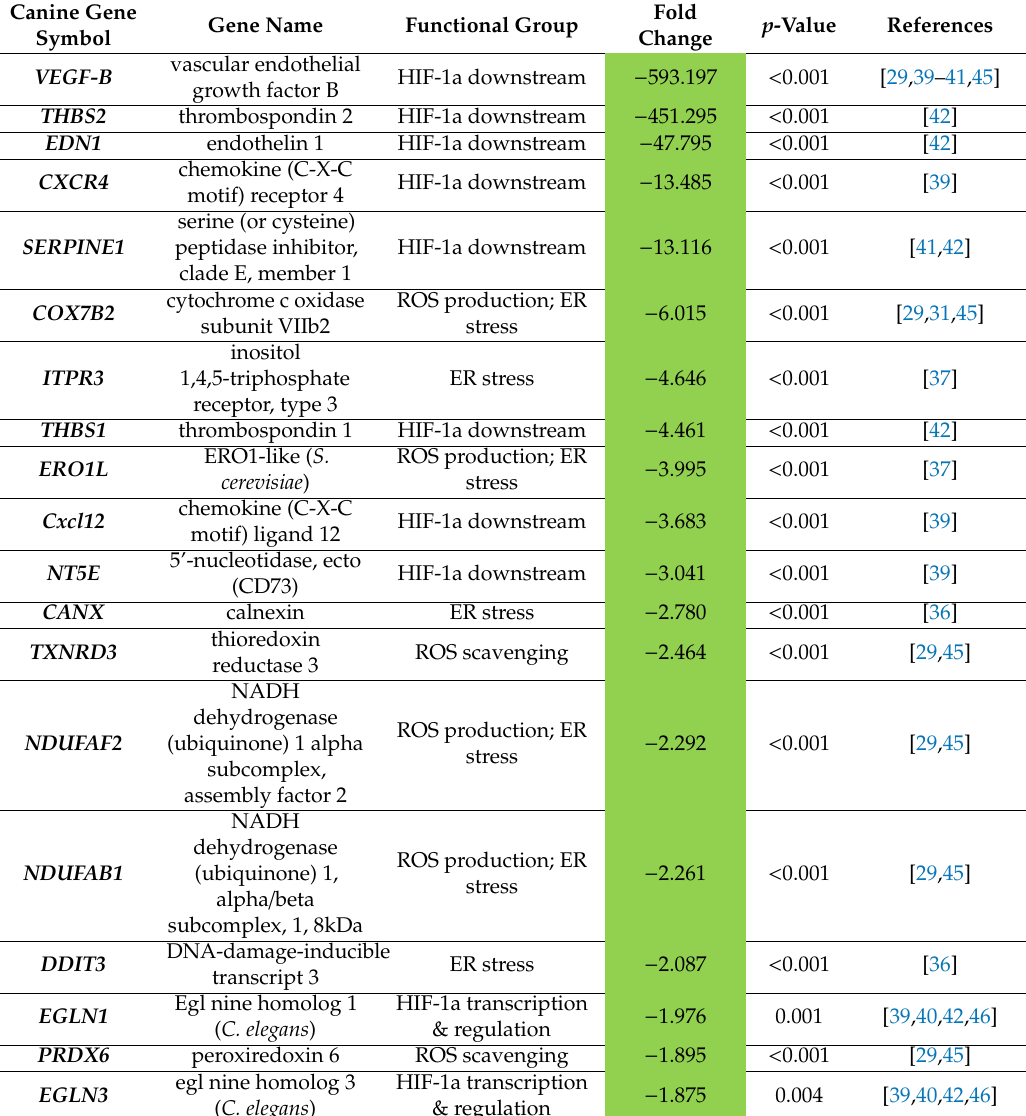
Table 2. Summary of canine gene symbols related to ROS production and scavenging, ER-stress and HIF-1 α pathway, di ff erentially expressed between non-infected and persistently canine distemper virus infected DH82 cells, according to the combination of a fold change (FC) filter (FC ≥ 1.5 or ≤ − 1.5) and of a statistical significances filter ( p ≤